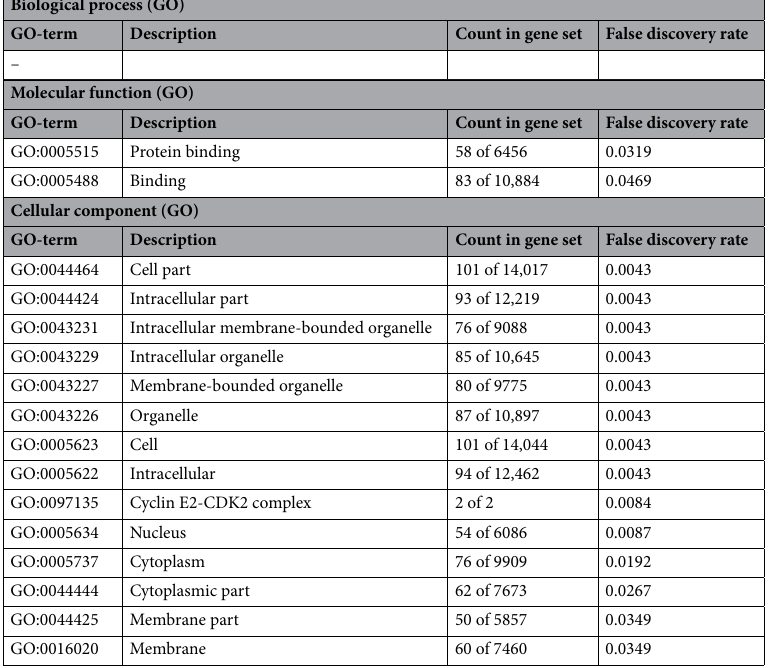
Table 3. GO-terms enrichment of differentially expressed genes after DS